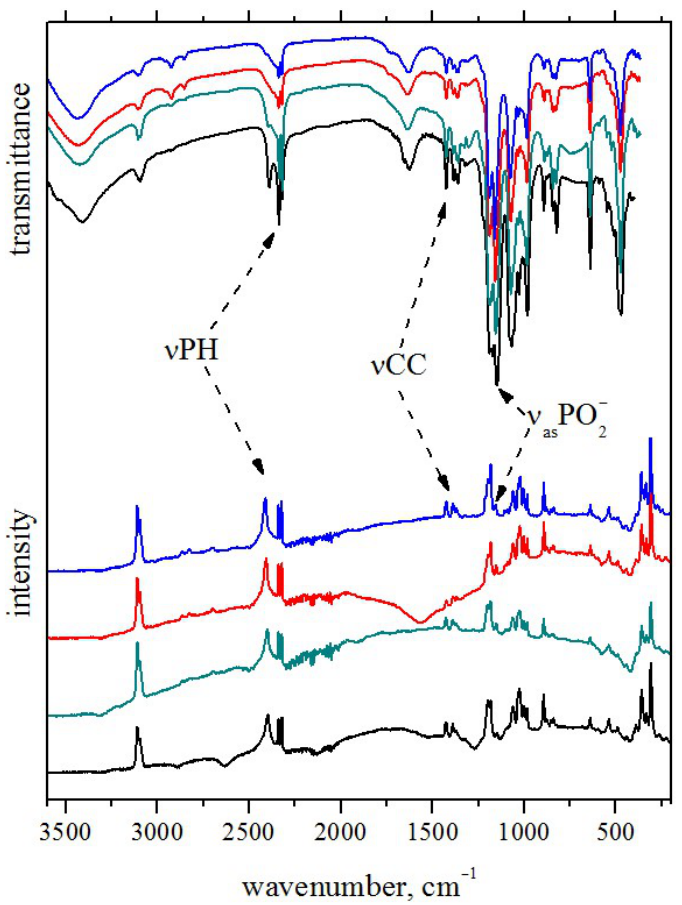
Figure 6. IR ( top ) and Raman ( bottom ) spectra of Sm (black), Dy (red), Y (blue), and Eu (dark cyan) coordination polymers.